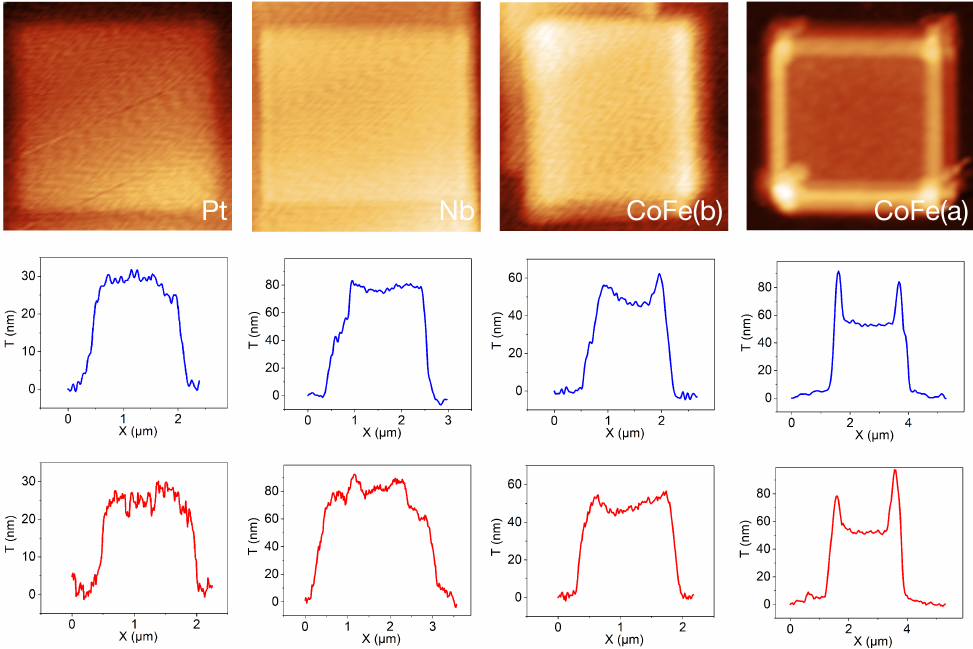
Figure 3. Topography (upper row) and line scans (middle and lower row) from atomic force microscope (AFM) measurements carried out on samples prepared at 15 ◦ C using the precursors as indicated: For each sample, a scan in the vertical direction (in blue) and horizontal direction (in red) is shown. The last two column of pictures, labeled CoFe (b) and CoFe (a) , refer to samples prepared in experiments b and a ,